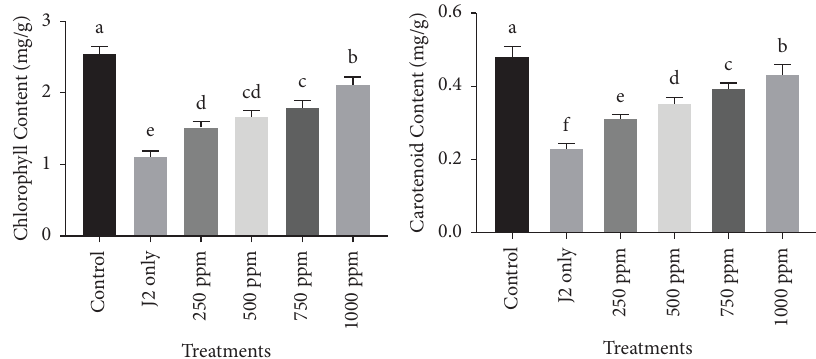
Figure 8: Efect of various concentrations (250, 500, 750, and 1000ppm) of G-ZnO NPs on the physiological attributes of chickpea.